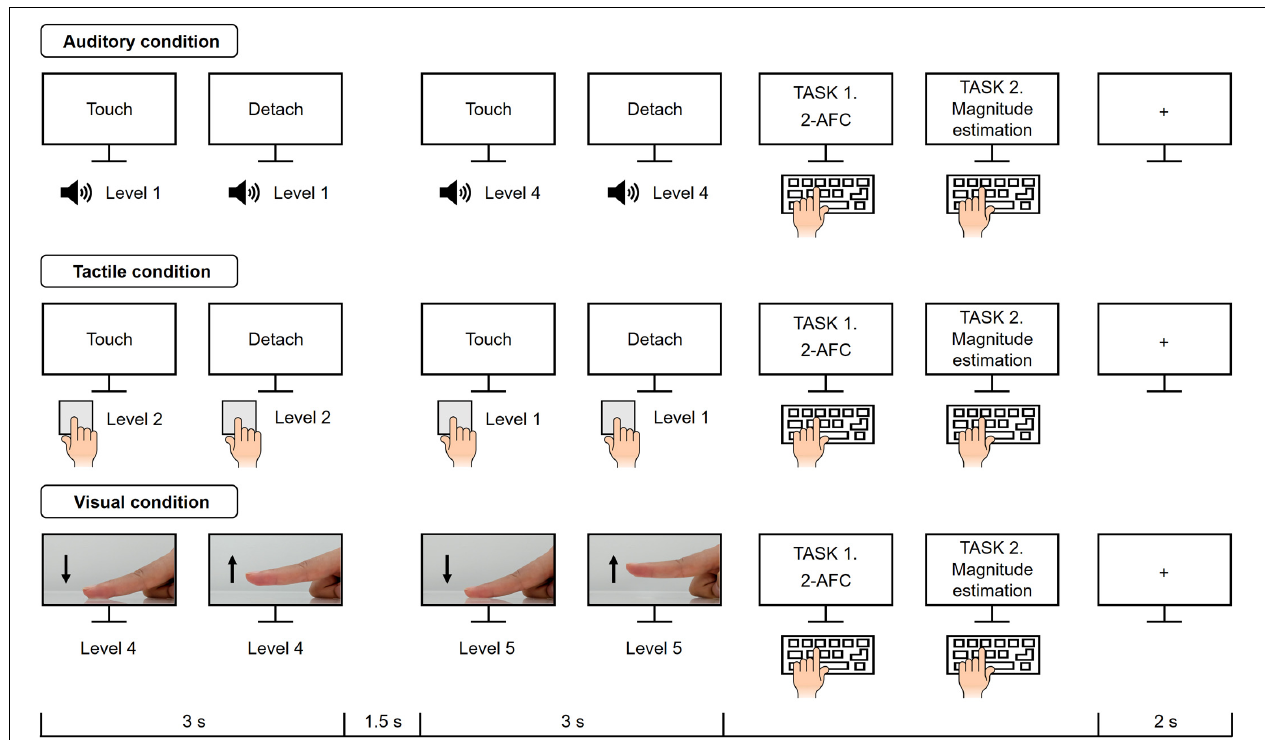
FIGURE 1 | Structure and time course of the experimental design. Participants completed five blocks per modality condition. Following the instruction on the screen, participants perceived stickiness intensity levels through the sensory cues, i.e., auditory, tactile, and visual cues. In each trial, two stimuli were presented one after another for 3 s each and then participants were asked to respond to questions (1) “Does the second stimulus feel stickier than the first one?” and (2) “How much stickier was the second stimulus compared to the first